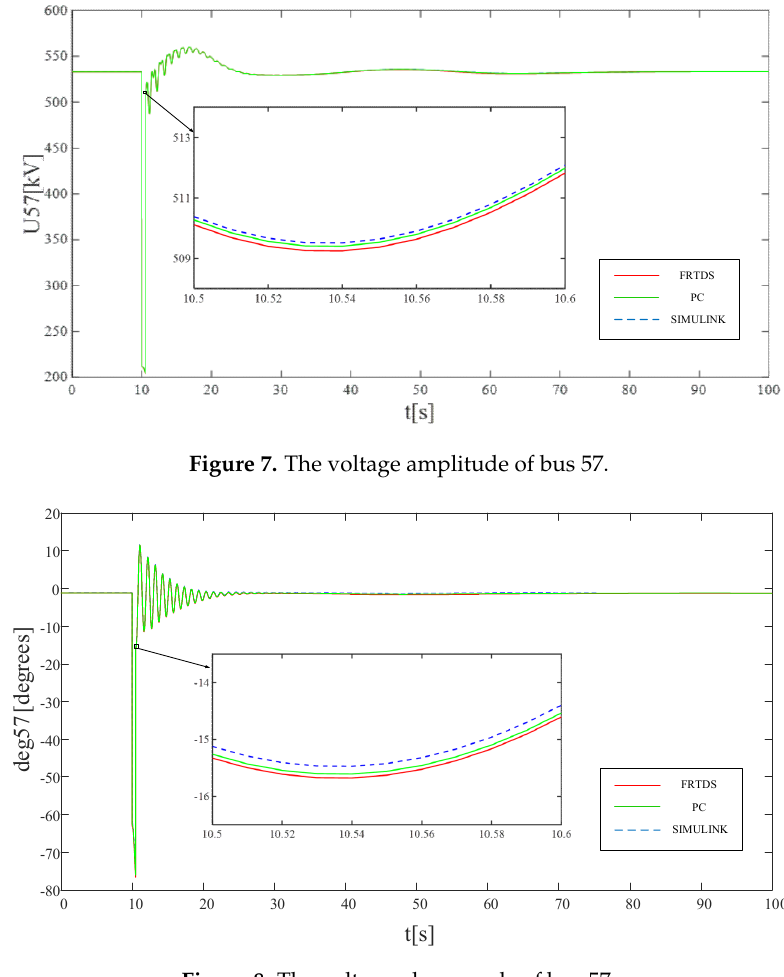
Figure 8. The voltage phase angle of bus 57.